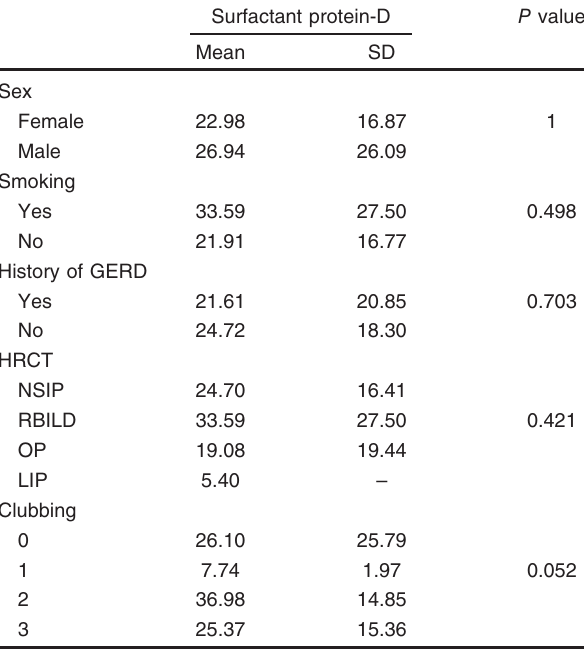
Table 6 The mean and SD of surfactant protein-D level in relation to sex, smoking, gastroesophageal reflux disease history, and clubbing among other idiopathic interstitial pneumonia groups 2